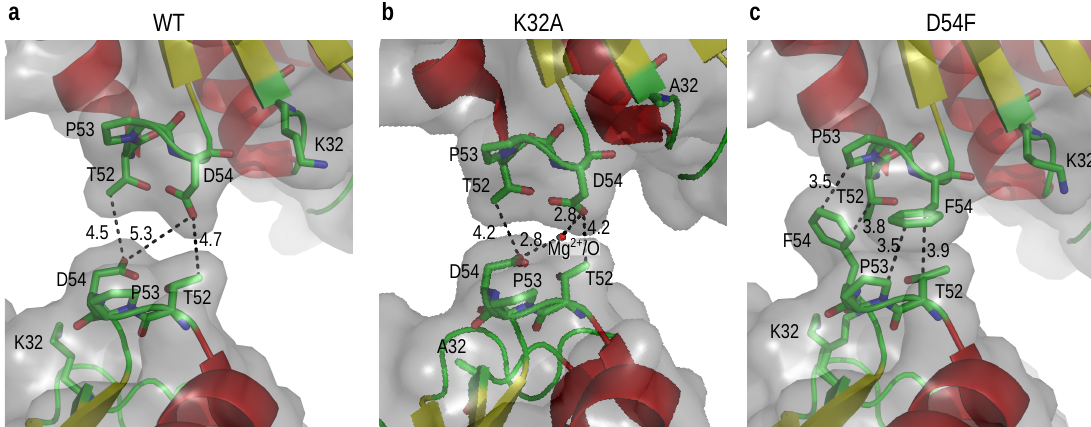
Figure 4. X-ray crystal structure of the edge contact for wild type, K32A, and D54F. The protein surface is displayed as transparent. ( a ) In wild type crystals, the polar side chains leave enough space to enable water mediated interactions across the crystal contact interfaces (wet contact). ( b ) In K32A crystals, the crystal contacts are in closer proximity, allowing additional coordination of an Mg 2 + ion. ( c ) In D54F crystals, nonpolar chains are in direct contact with no space for water molecules (dry contact). All distances are given in